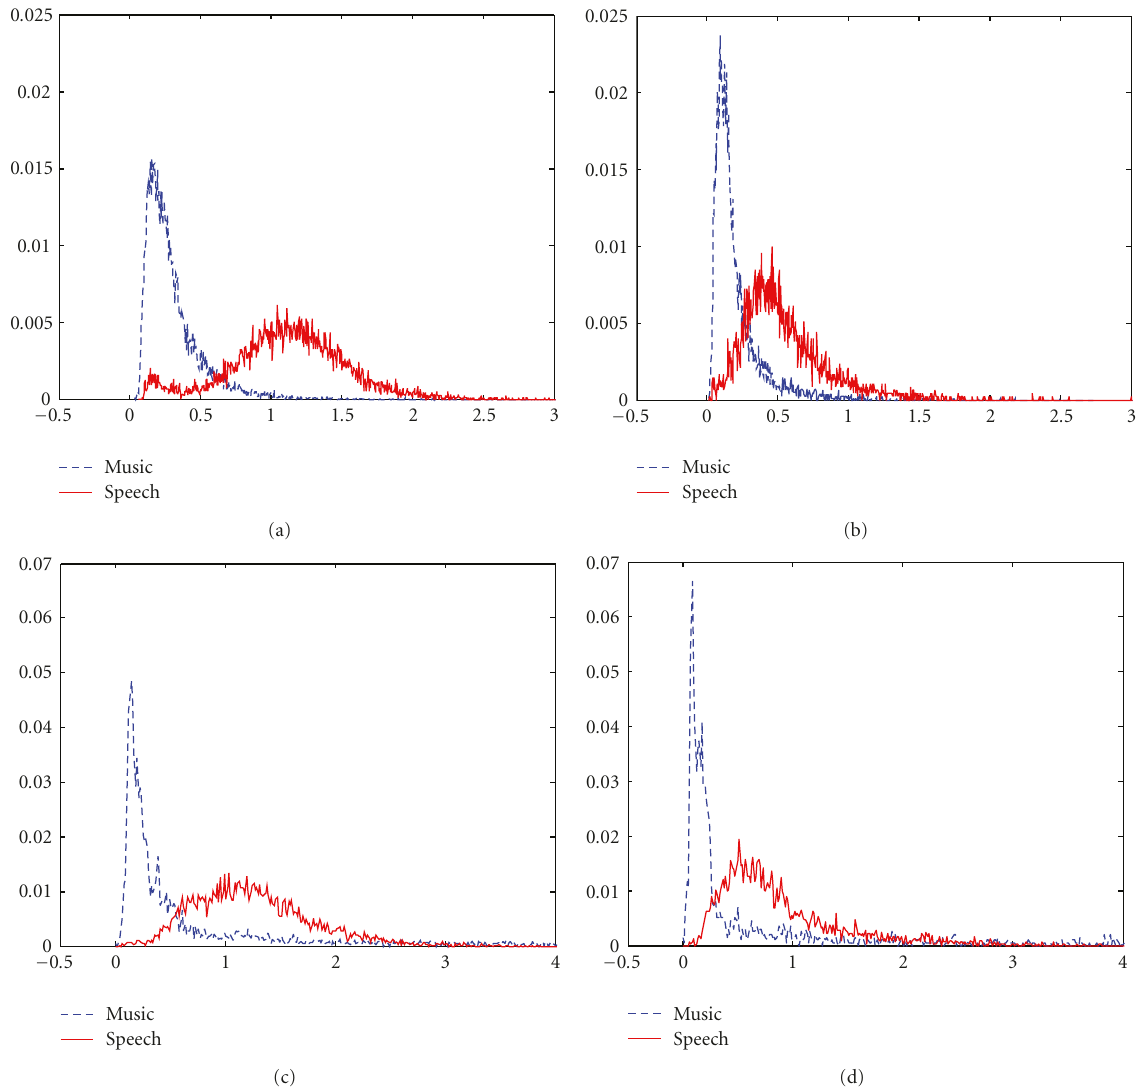
Figure 4: Histograms of (a) VMFBE feature on radio broadcast database, (b) Var. of SF feature on radio broadcast database, (c) VMFBE feature on BNSI database and (d) Var. of SF feature on BNSI